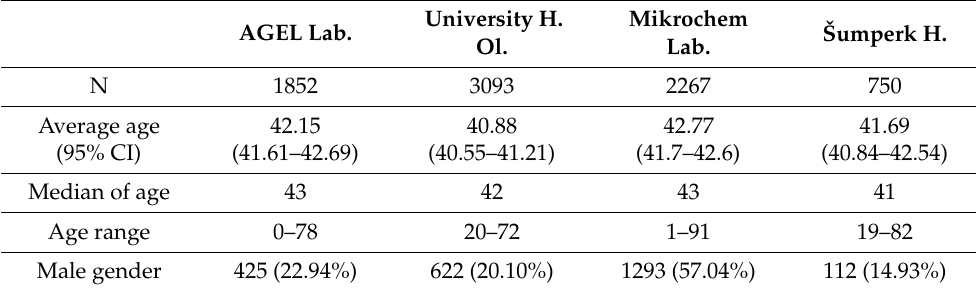
Table 1. Basic characteristics of the study population. AGEL